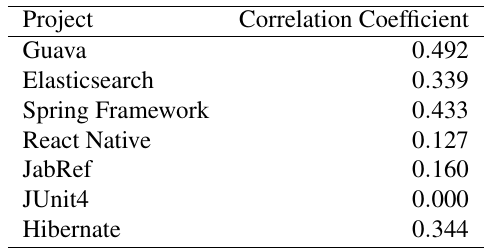
Table 6. Spearman rank correlation coefficients between the set of single-authored files and that of multi-authored ones in terms of NIPA value.